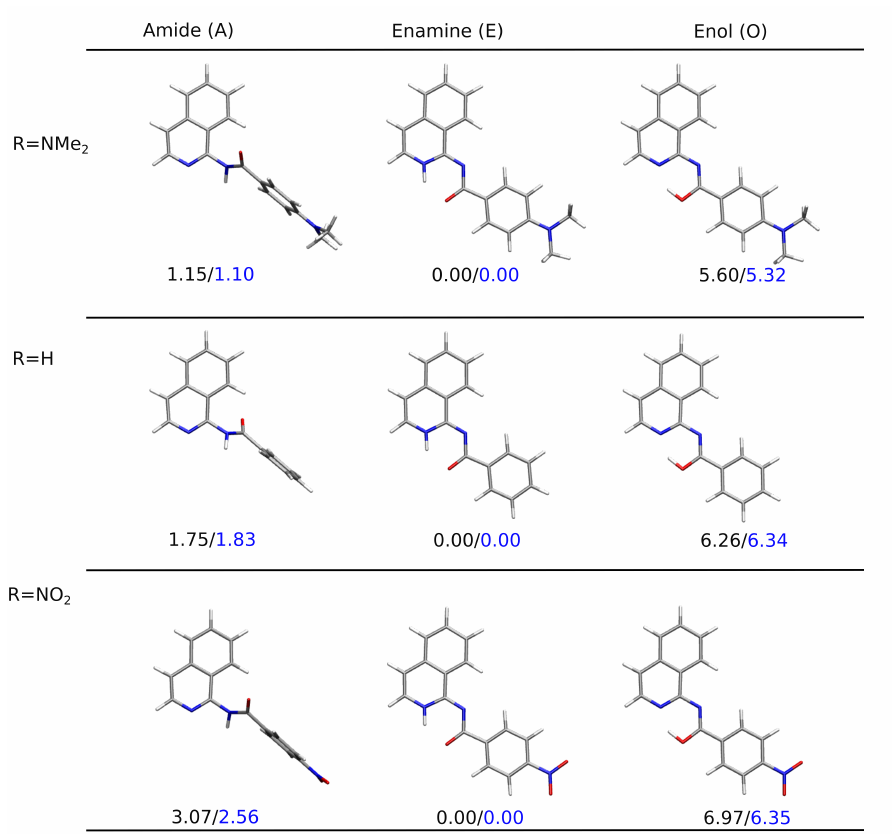
Figure 4. Optimized structures for the tautomeric forms of NMe 2 , H, and NO 2 -substituted derivatives ( 1 , 5 , and 10 ) together with the relative energies (in black) and the relative Gibbs free energies (in blue) in kcal/mol ( ω B97X-D/def2-TZVP/PCM(DMSO)